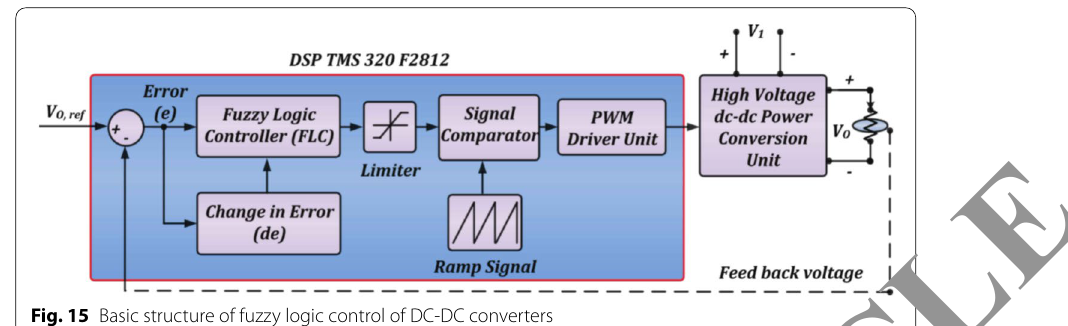
Fig. 15 Basic structure of fuzzy logic control of DC-DC converters